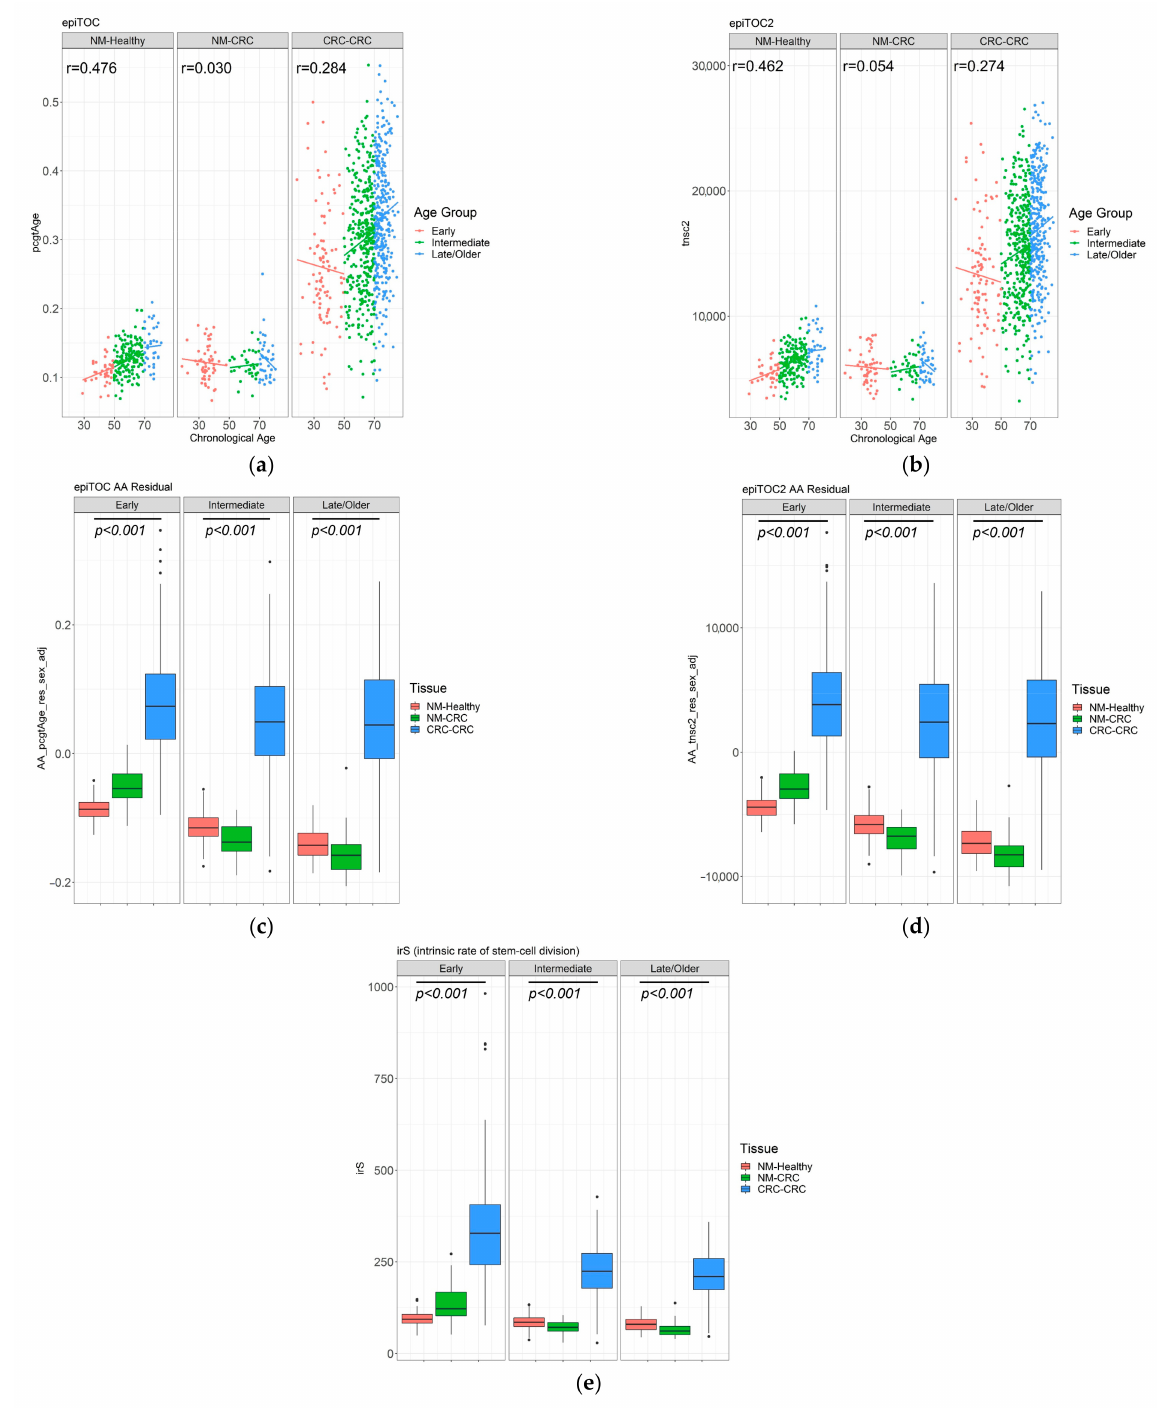
Figure 4. The mitotic-based DNAms age prediction by epiTOC and epiTOC2 for normal colonic mucosa samples from people without (“NM-Healthy”) and people with CRC (“NM-CRC”), and CRC tumour (“CRC-CRC”) samples, separated into Early, Intermediate and Late/Older age groups based on the age at tissue collection or CRC diagnosis. ( a ) Scatterplots illustrating correlations between chronological age ( x -axis) and epiTOC DNAm-based age ( y -axis) for corresponding samples. ( b ) Scatterplots illustrating correlation between chronological age and epiTOC2 DNAm-based age ( y -axis). Boxplots illustrating the distribution of age-acceleration (AA) as estimated using epiTOC ( c ), epiTOC2 ( d ), and irS (average lifetime intrinsic rate of stem-cell division per sample), as derived from epiTOC2 ( e ), shown separately by the age and the tissue groups. P -values were obtained from Kruskal-Wallis Rank Sum